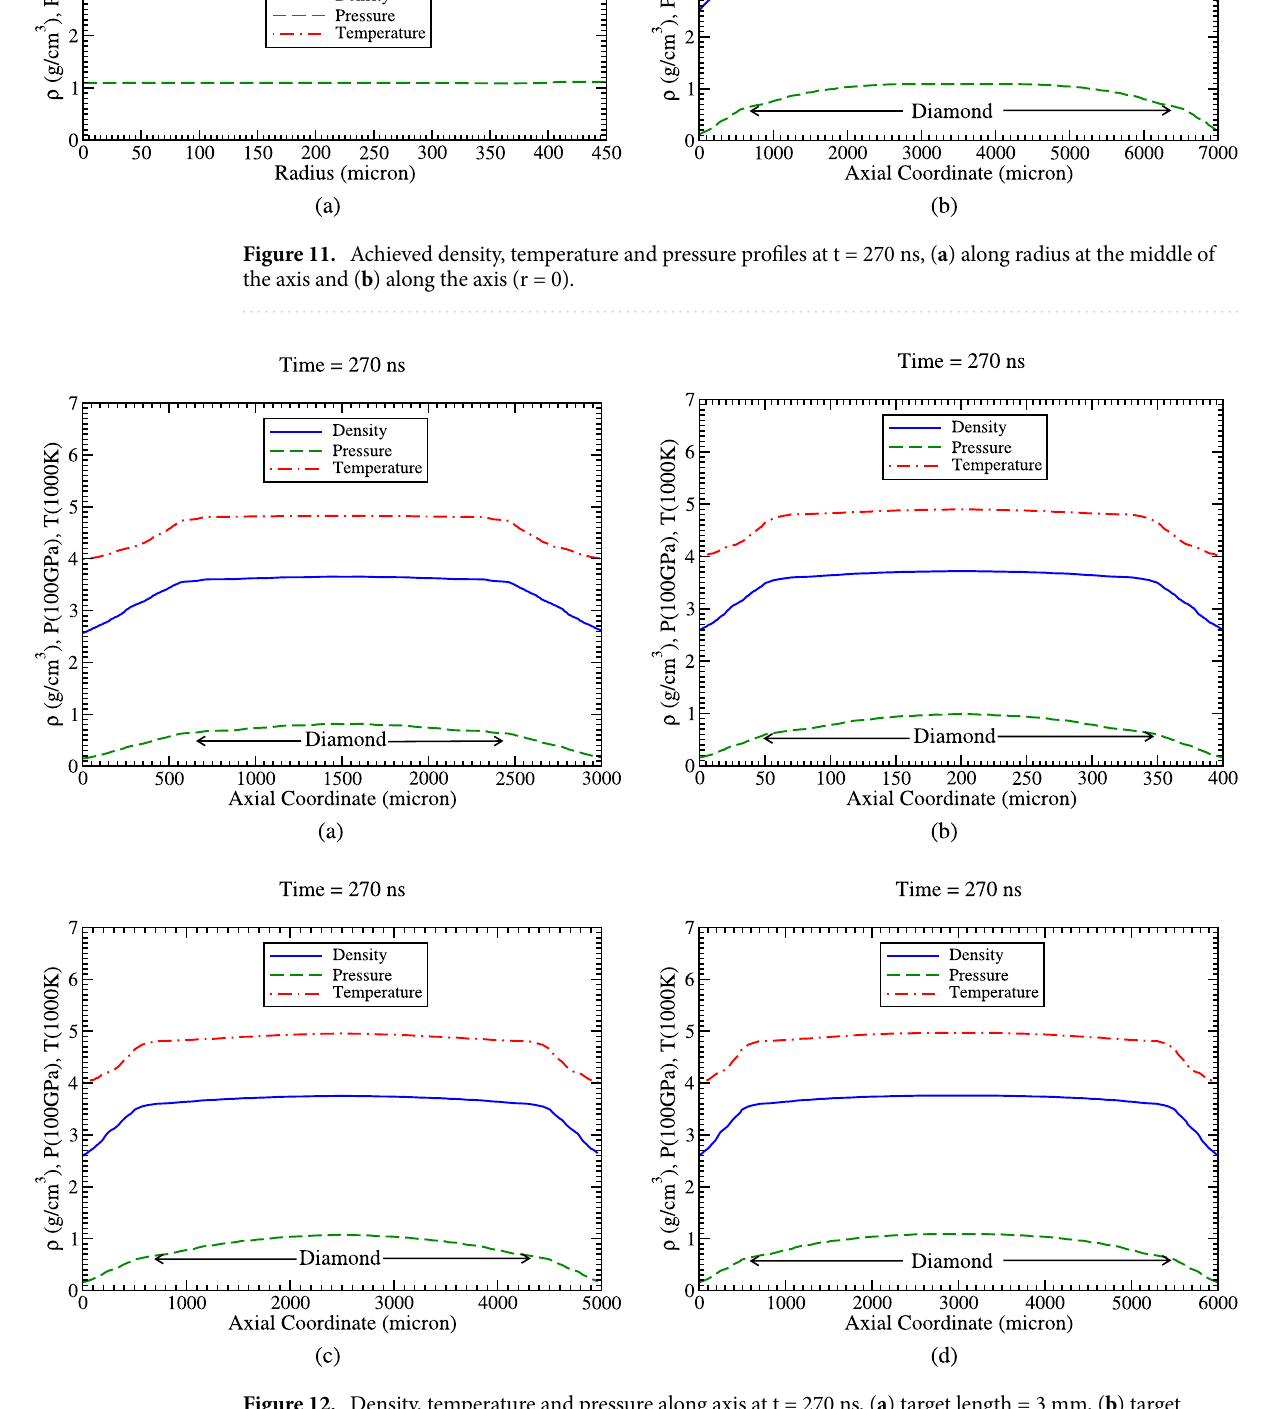
Figure 12. Density, temperature and pressure along axis at t = 270 ns, ( a ) target length = 3 mm, ( b ) target length = 4 mm, ( c ) target length = 5 mm and ( d ) target length = 6